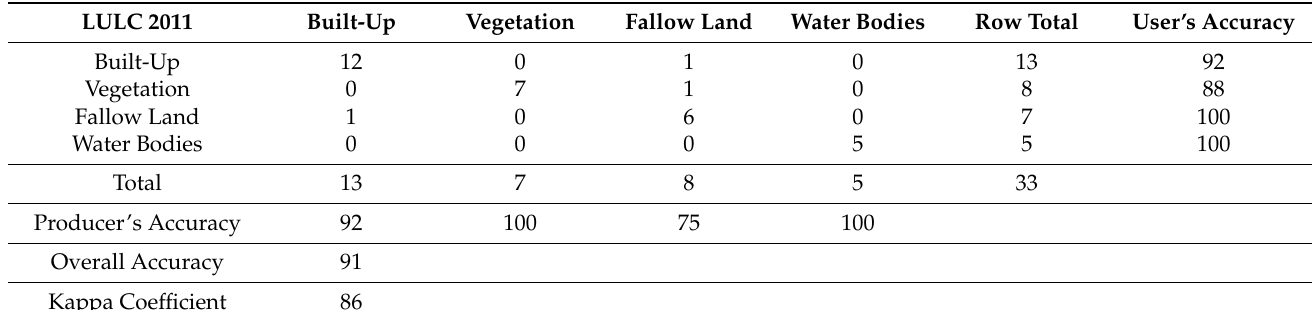
Table A2. Accuracy assessment of